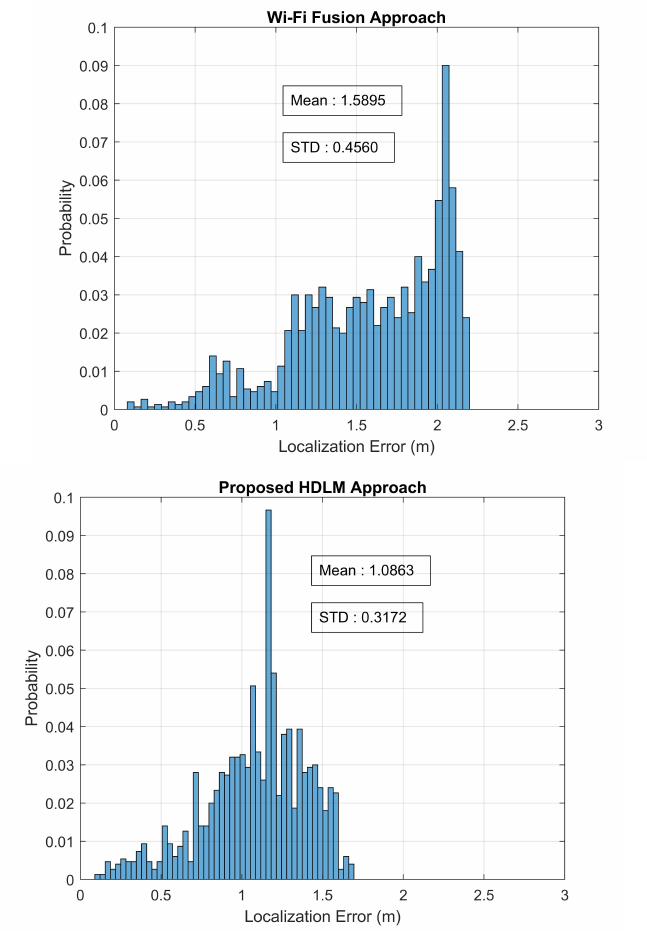
Figure 11. Probability distribution of localization